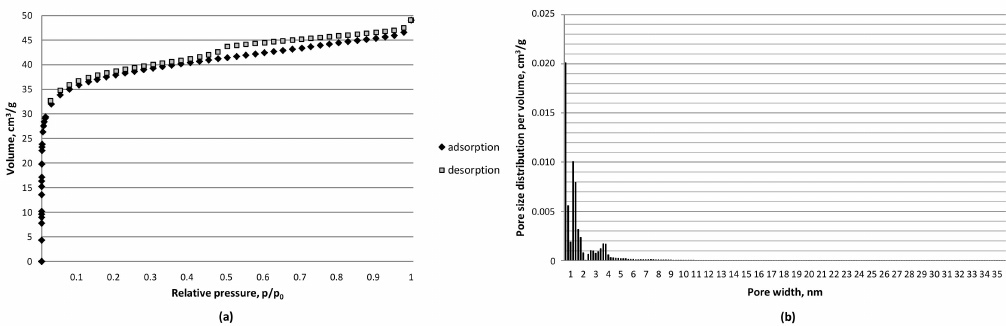
Figure 2. Nitrogen isotherm ( − 196 ◦ C) ( a ) and pore size distribution per pore volume ( b ) for olive pomace-derived carbon materials produced at 800 ◦ C, under carbon dioxide atmosphere and pressure of 3 MPa.